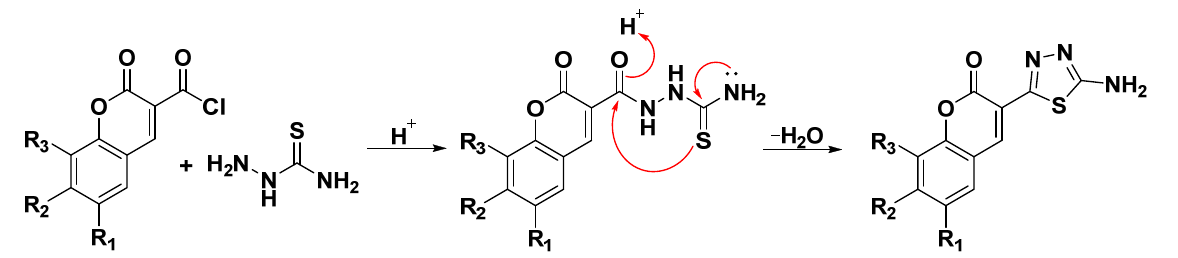
Figure 3. Formation of the coumarin–thiadiazole hybrids 1-12 from coumarin-3-carbonyl chloride intermediates.